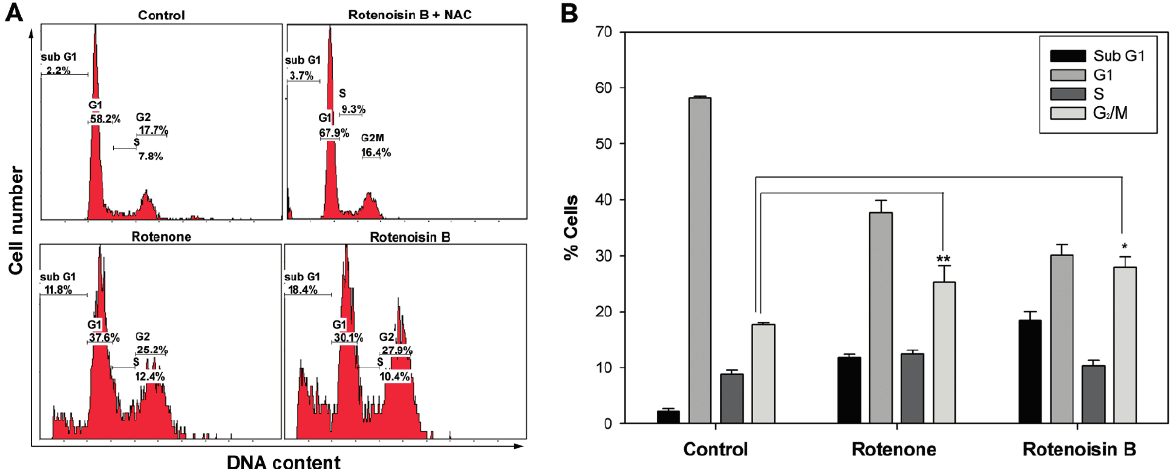
Figure 4. ( A ) Flow cytometry analysis of cell cycle distribution of rotenone and rotenoisin B in Huh-7 hepatic cancer cells; and ( B ) The data are the mean ± SD of the three different experiments ( * p < 0.05, ** p <